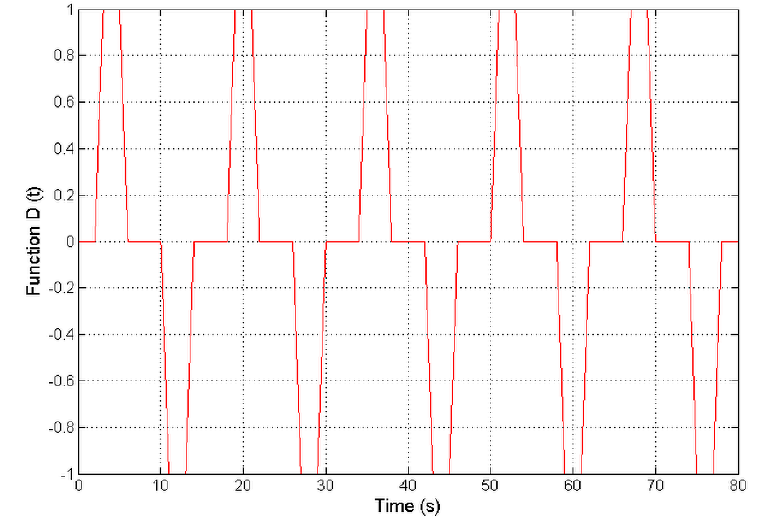
Figure 3. Representative curve of the D ( t ) function.